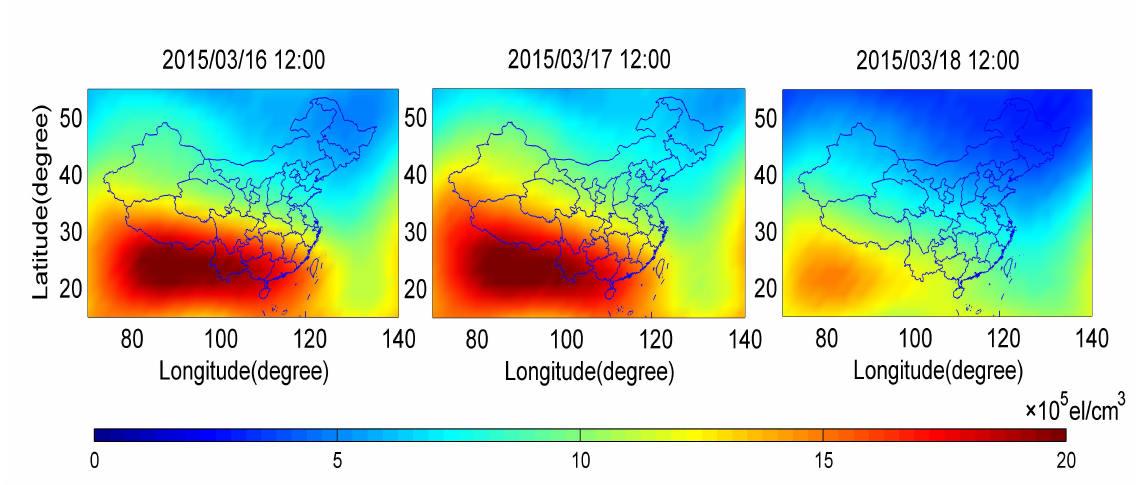
Figure 8. Horizontal distribution of IED at UTC 12:00 from 16–18 March 2015 (H = 350